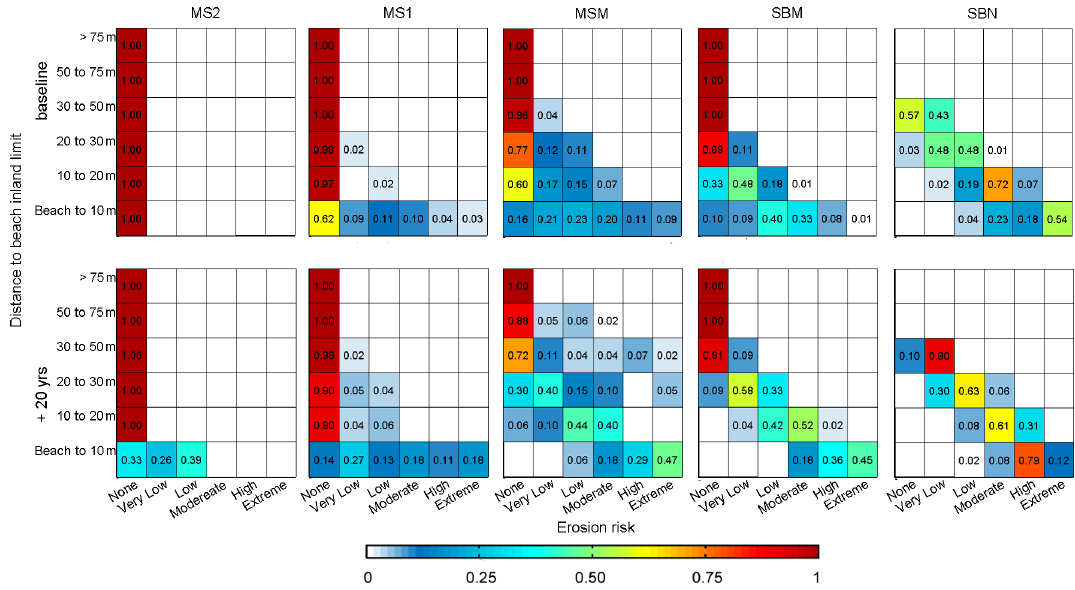
Figure 12. Probability distributions of the erosion risk conditioned to the different subareas (see Fig. 7.1 for locations) and the distance to the inner limit of the beach. Baseline and + 20-year time horizon of background shoreline retreat. Results must be read horizontally as individual histograms for each combination of area, distance, and